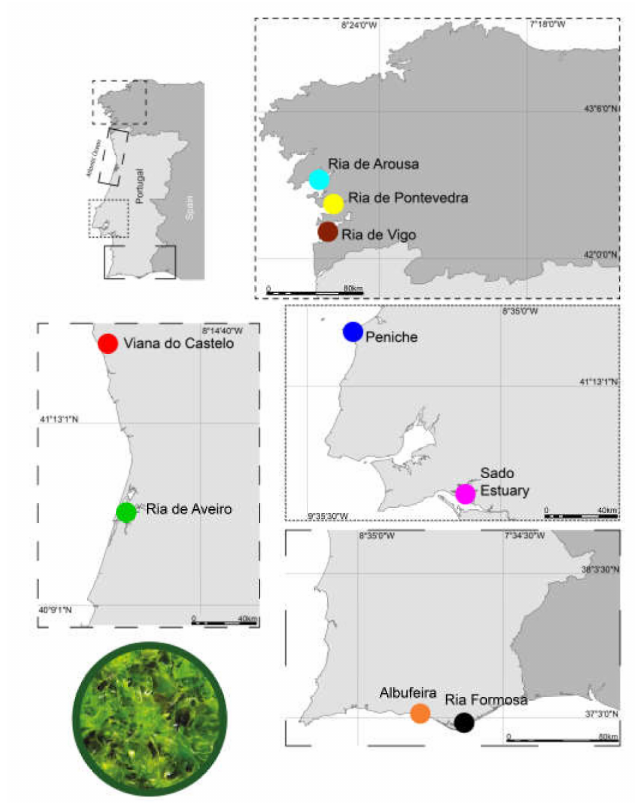
Figure 1. Sampling locations of Ulva spp. along the Atlantic western and southwestern Iberian coast: Albufeira (Al), Peniche (Pe), Ria de Arousa (RAr), Ria de Aveiro (RAv), Ria Formosa (RF), Ria de Pontevedra (RP), Ria de Vigo (RV), Sado Estuary (SE), and Viana do Castelo